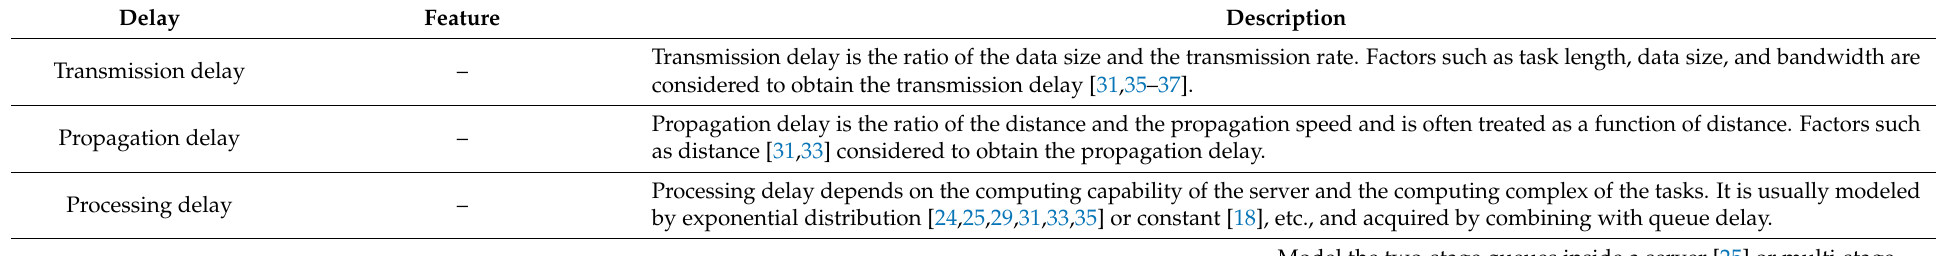
Table 1. Comparative table of related